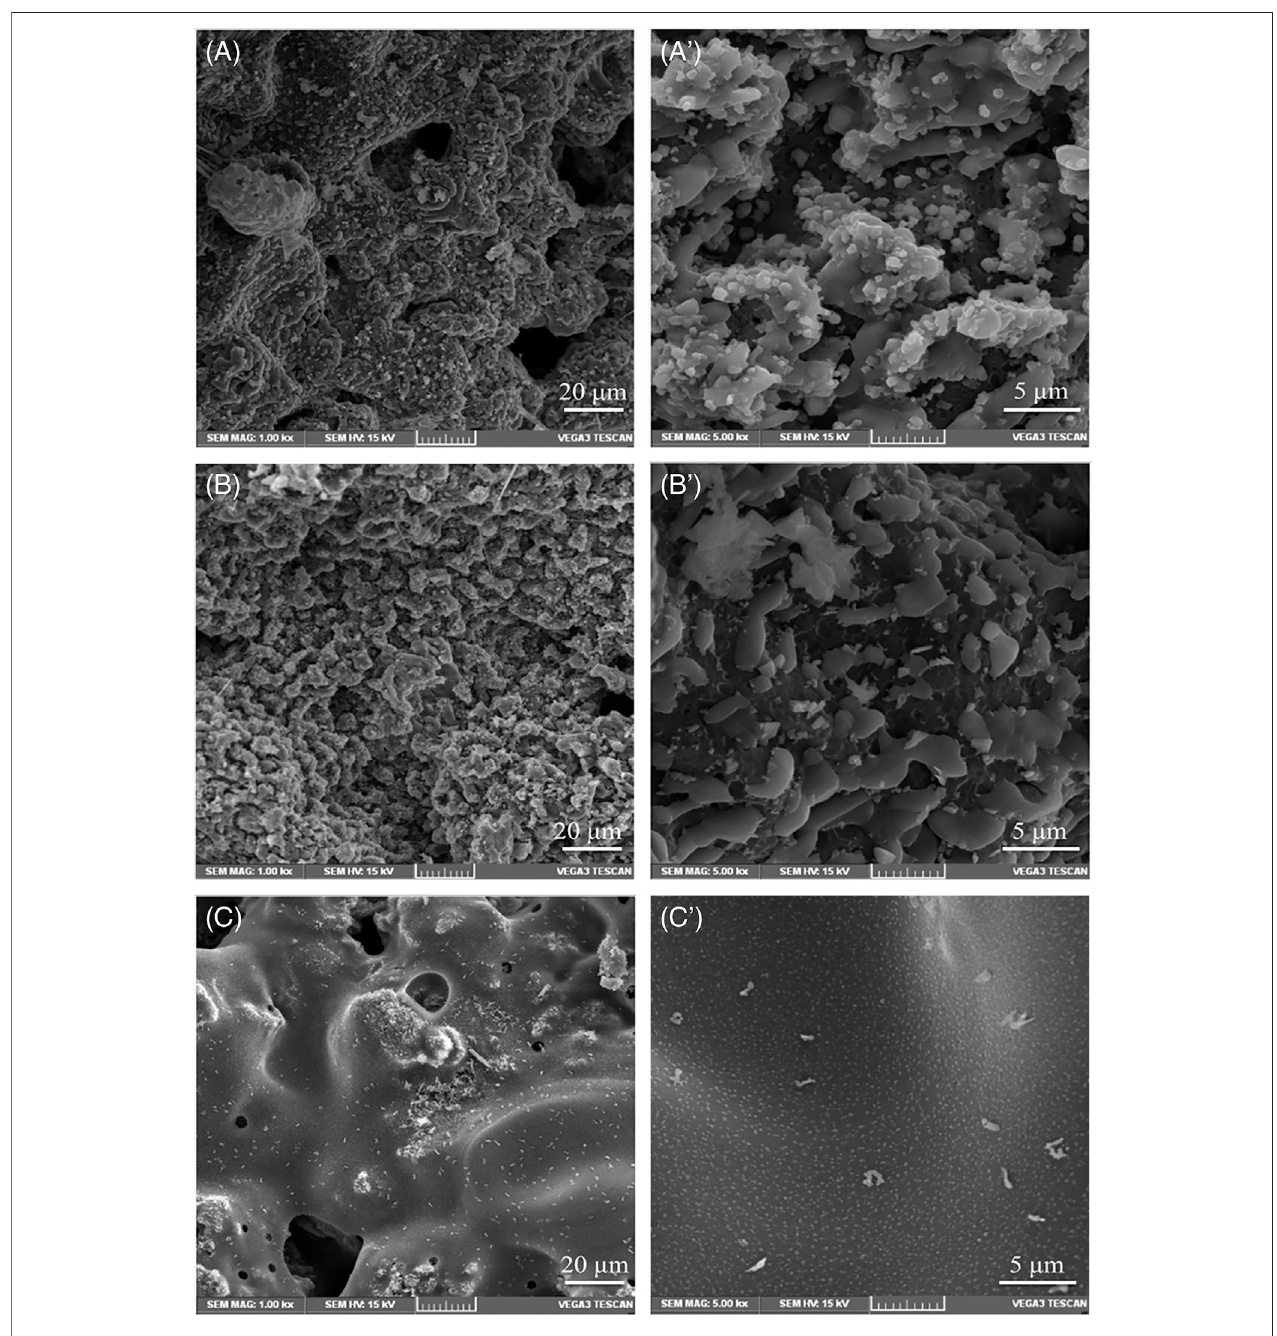
FIGURE 13 | Scanning electron microscopy (SEM) images of the chars for PBS composites with (A , A 9 ) 10 wt% CP-lignin, (B , B 9 ) 20 wt% CP-lignin, and (C , C 9 ) 30 wt% CP-lignin after cone calorimeter tests (Chen et al., 2018).